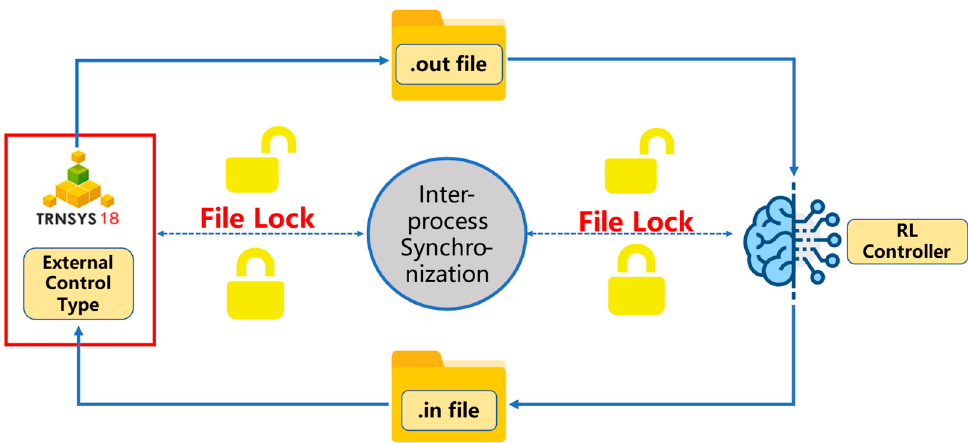
Figure 3. Schematic diagram of data transfer.